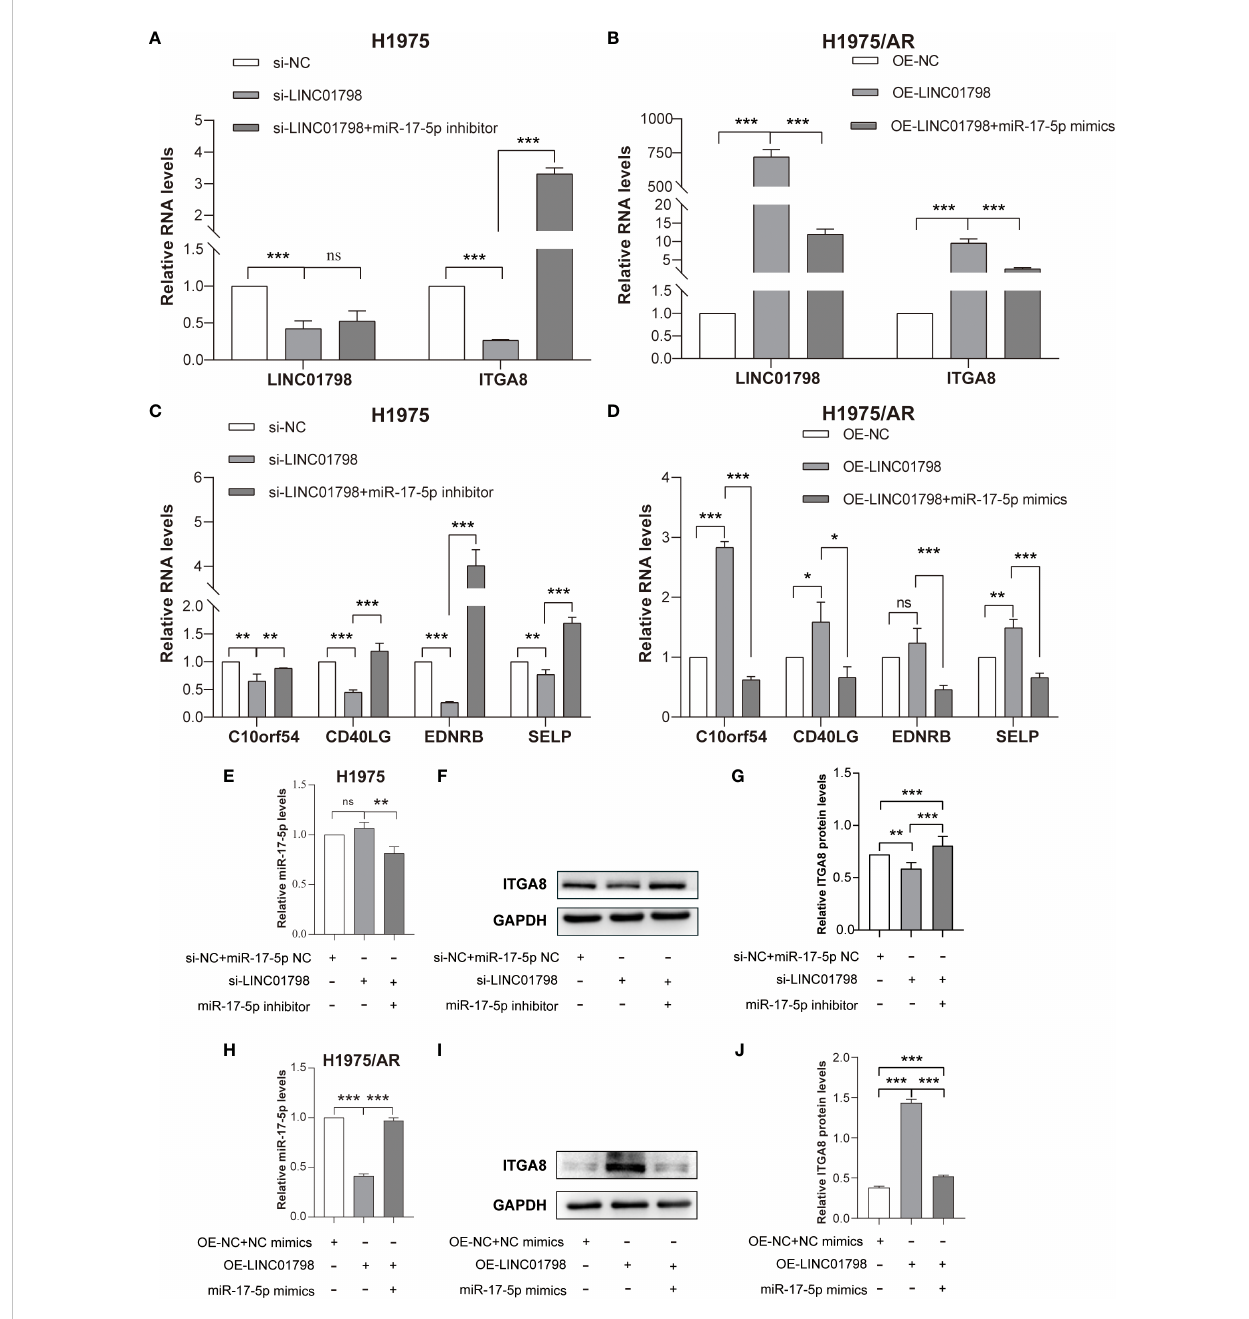
FIGURE 8 Reciprocal correlation among LINC01798, miR-17-5p, and ITGA8. (A) Relative RNA levels of LINC01798 and ITGA8 in H1975 after being transfected with si- NC + miR-17-5p inhibitor NC, si-LINC01798, and si-LINC01798 + miR-17-5p inhibitor. (B) Relative RNA levels of LINC01798 and ITGA8 in H1975/AR after being transfected with pcDNA3.1-NC + NC mimics, pcDNA3.1-LINC01798, and pcDNA3.1-LINC01798 + miR-17-5p mimics. (C) Relative mRNA levels of immune checkpoint genes in H1975 after being transfected with si-NC + miR-17-5p inhibitor NC, si-LINC01798, and si-LINC01798 + miR-17-5p inhibitor. (D) Relative mRNA levels of immune checkpoint genes in H1975/AR after being transfected with pcDNA3.1-NC + NC mimics, pcDNA3.1-LINC01798, and pcDNA3.1-LINC01798 + miR-17-5p mimics. (E) Relative miR-17-5p level in H1975 after being transfected with si-NC + miR-17-5p inhibitor NC, si- LINC01798, and si-LINC01798 + miR-17-5p inhibitor. (F, G) Relative protein level of ITGA8 in H1975 after being transfected with si-NC + miR-17-5p inhibitor NC, si-LINC01798, and si-LINC01798 + miR-17-5p inhibitor. (H) Relative miR-17-5p level in H1975/AR after being transfected with pcDNA3.1-NC + NC mimics, pcDNA3.1-LINC01798, and pcDNA3.1-LINC01798 + miR-17-5p mimics. (I, J) Relative protein level of ITGA8 in H1975/AR after being transfected with pcDNA3.1-NC + NC mimics, pcDNA3.1-LINC01798, and pcDNA3.1-LINC01798 + miR-17-5p mimics. * p < 0.05, ** p < 0.01, *** p < 0.001, ns (not statistically signi fi cant) p >